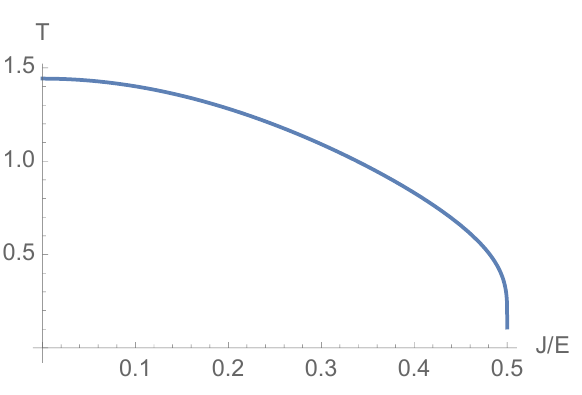
Figure 4 . Temperature versus charge. The plot is symmetric on J ! (cid:0) J , so negative J is not